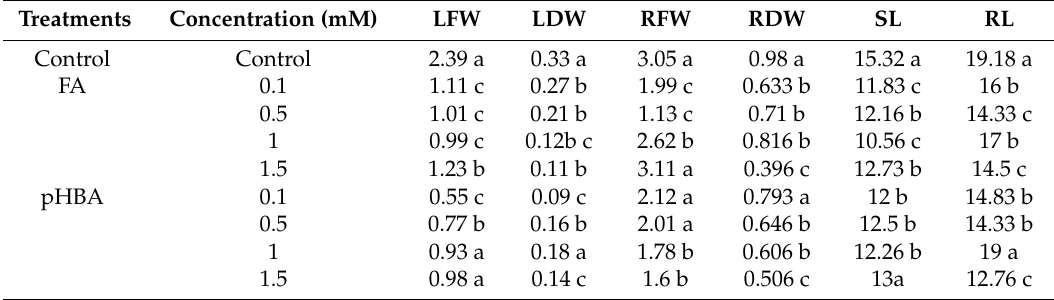
Table 2. Effect of ferulic acid (FA) and p-hydroxybenzoic acid (pHBA) at different concentrations (0,